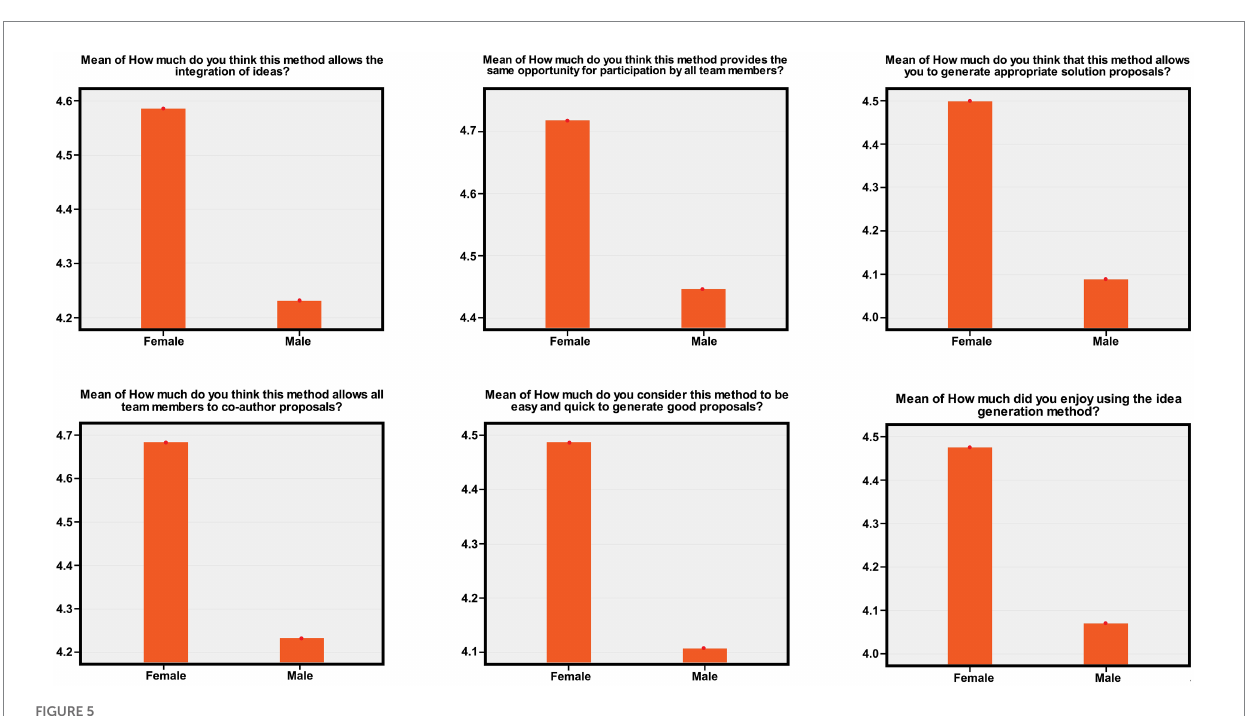
FIGURE 5 Plots of means for gender and perception-experience